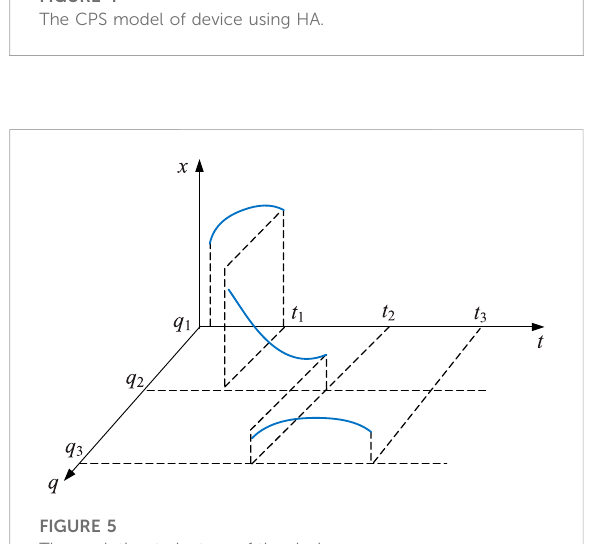
FIGURE 4 The CPS model of device using HA.